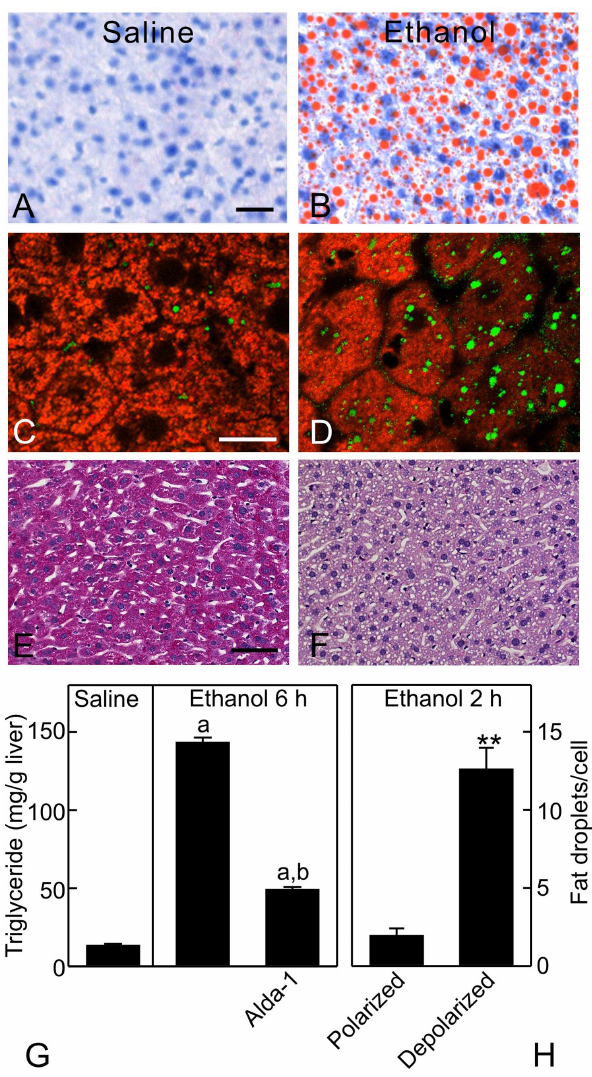
Figure 11. Ethanol causes steatosis in hepatocytes with depolarized mitochondria. Mice were gavaged with saline or ethanol (6 g/kg), and livers were collected 6 h later for Oil-Red-O ( A and B ; bar is 20 m m), PAS staining ( E and F ; bar is 50 m m), and triglyceride measurement ( G ). In G , some mice were injected with vehicle or Alda-1 (50 mg/kg, i.p. ) 30 min before gavage of saline or ethanol (6 g/kg). Values are means 6 SEM (n=4 per group). a, p , 0.05 vs saline; b, p , 0.05 vs ethanol without Alda-1. Intravital confocal microscopy of TMRM (red) and BODIPY 493/503 (green) was performed after 2 h ( C and D ; bar is 10 m m). Representative images from 4 mice per group are shown. H shows the average number of fat droplets per cell in hepatocytes with polarized and depolarized mitochondria. **, p , 0.01 compared to polarized (n=4 per group).